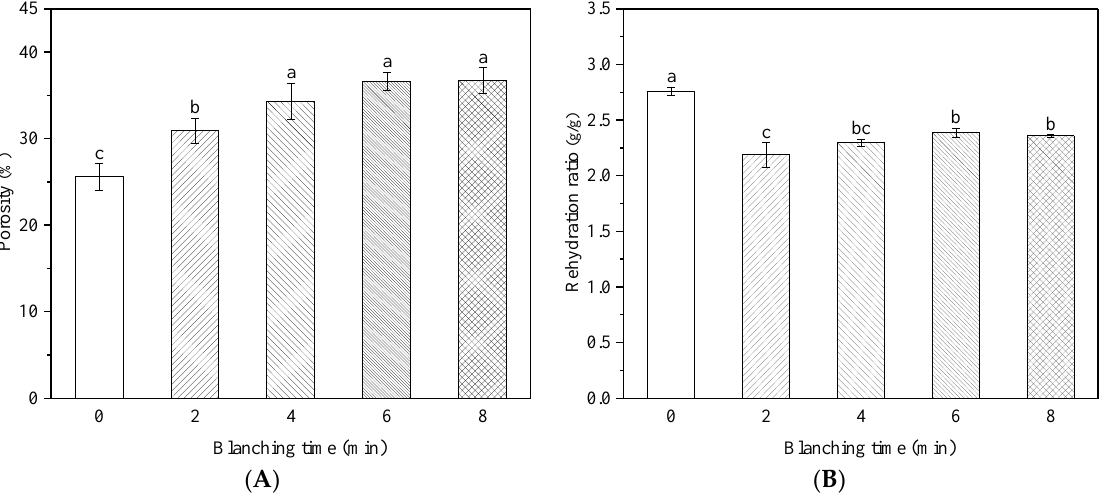
Figure 6. Porosity ( A ) and rehydration properties ( B ) of A. sessiliflorus fruits with different blanching durations. Different letters indicate significant differences ( p < 0.05) according to the Duncan test.